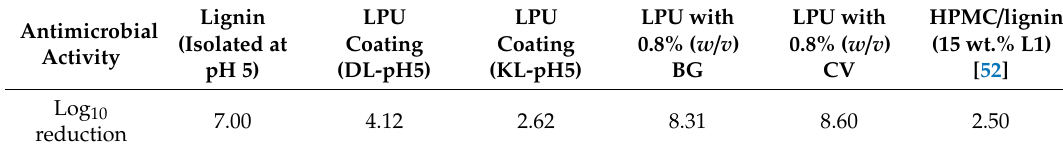
coatings was added in this table, previously reported in [52].